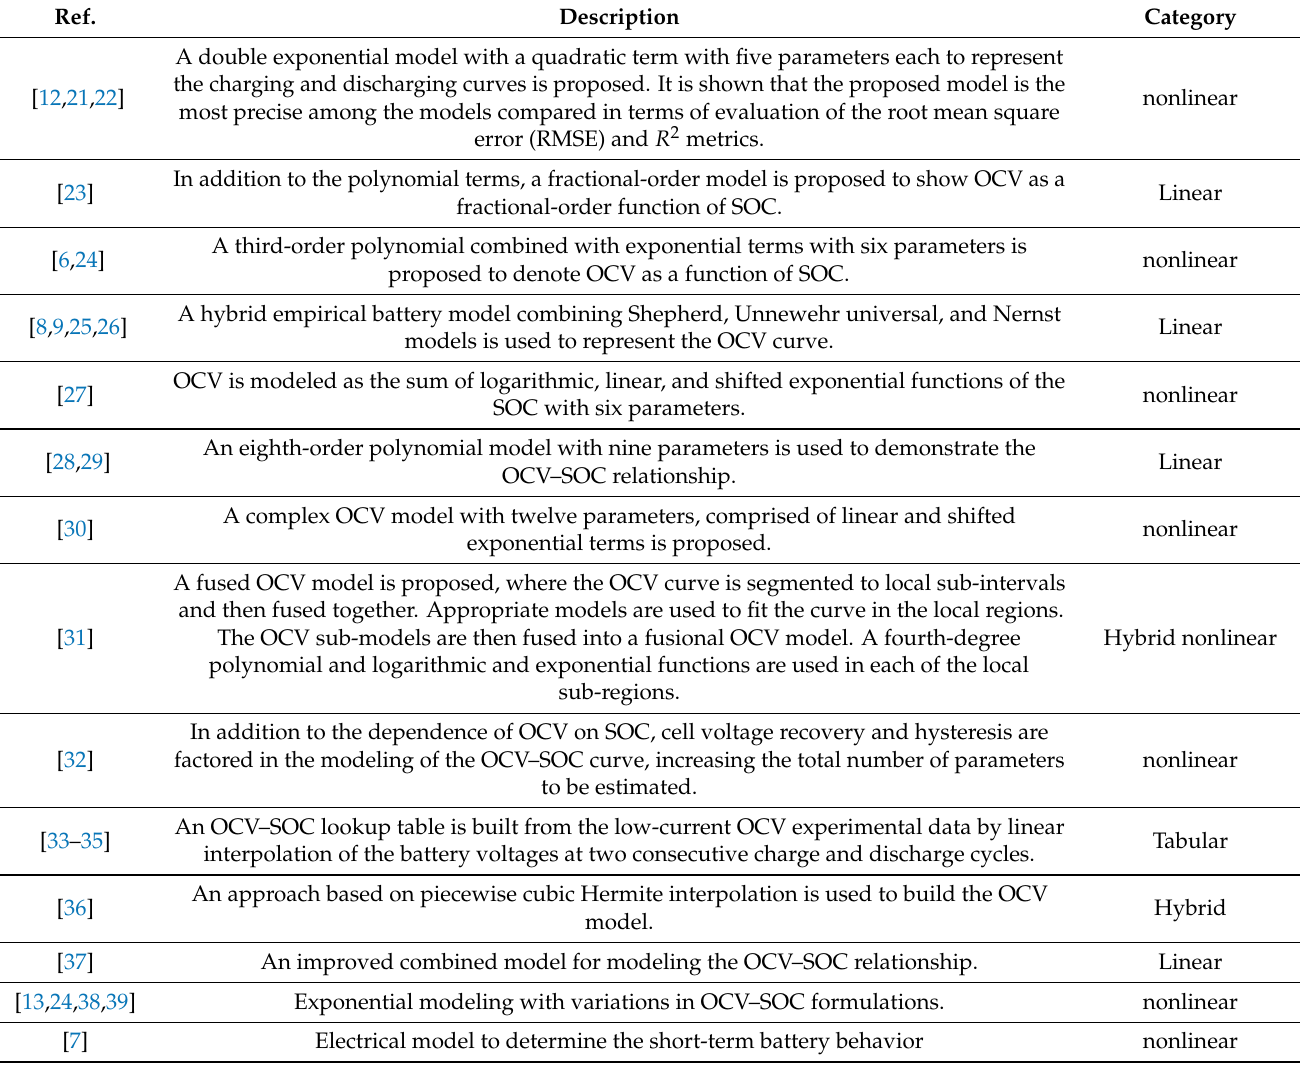
Table 1. Literature review OCV modeling